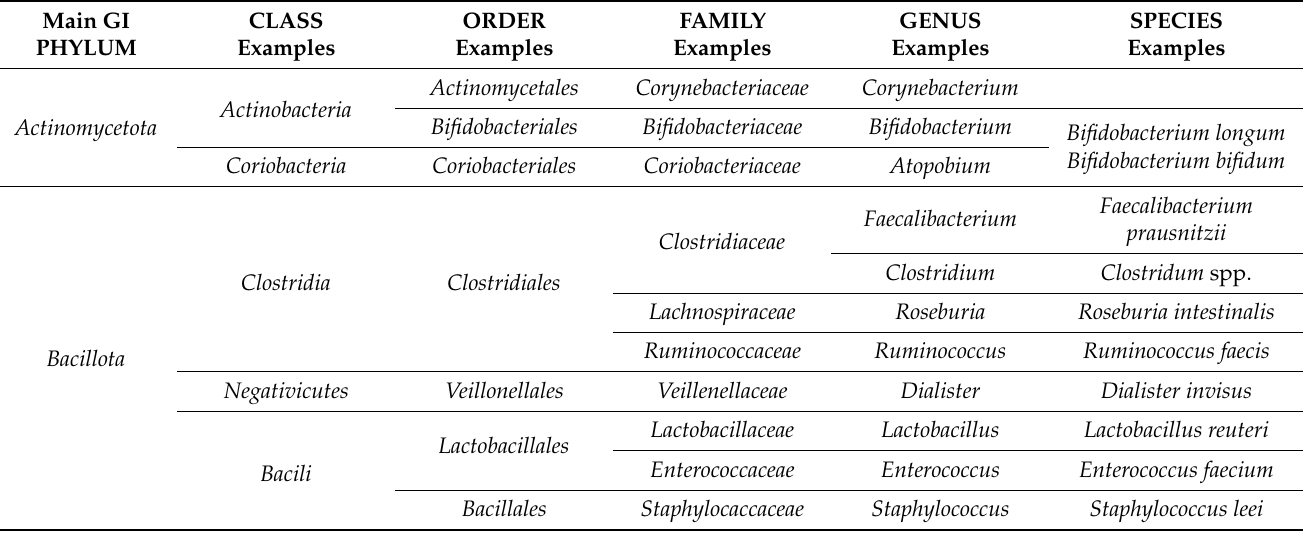
Table 1. Main representatives for taxonomic gut microbial composition, adapted from Rinninella et al.